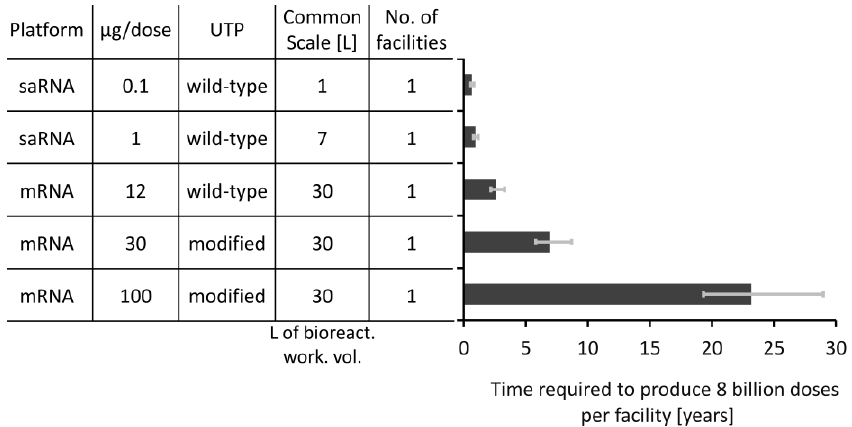
Figure 4. The time required to produced 8 billion doses worth of LNP formulated drug substance for the five RNA vaccine types. The times required per facility are shown on the x-axis and the five vaccine types together with their key features are shown in the table belonging to the y-axis. For this comparison it was assumed that a single facility housing a single production line at the techno-economically feasible scale is used. The error bars represent the low and high productivity scenarios which were obtained by adjusting the titre by ±20% from its baseline value of 5 g/L which corresponds to the medium scenario shown by the vertical bars of the chart.